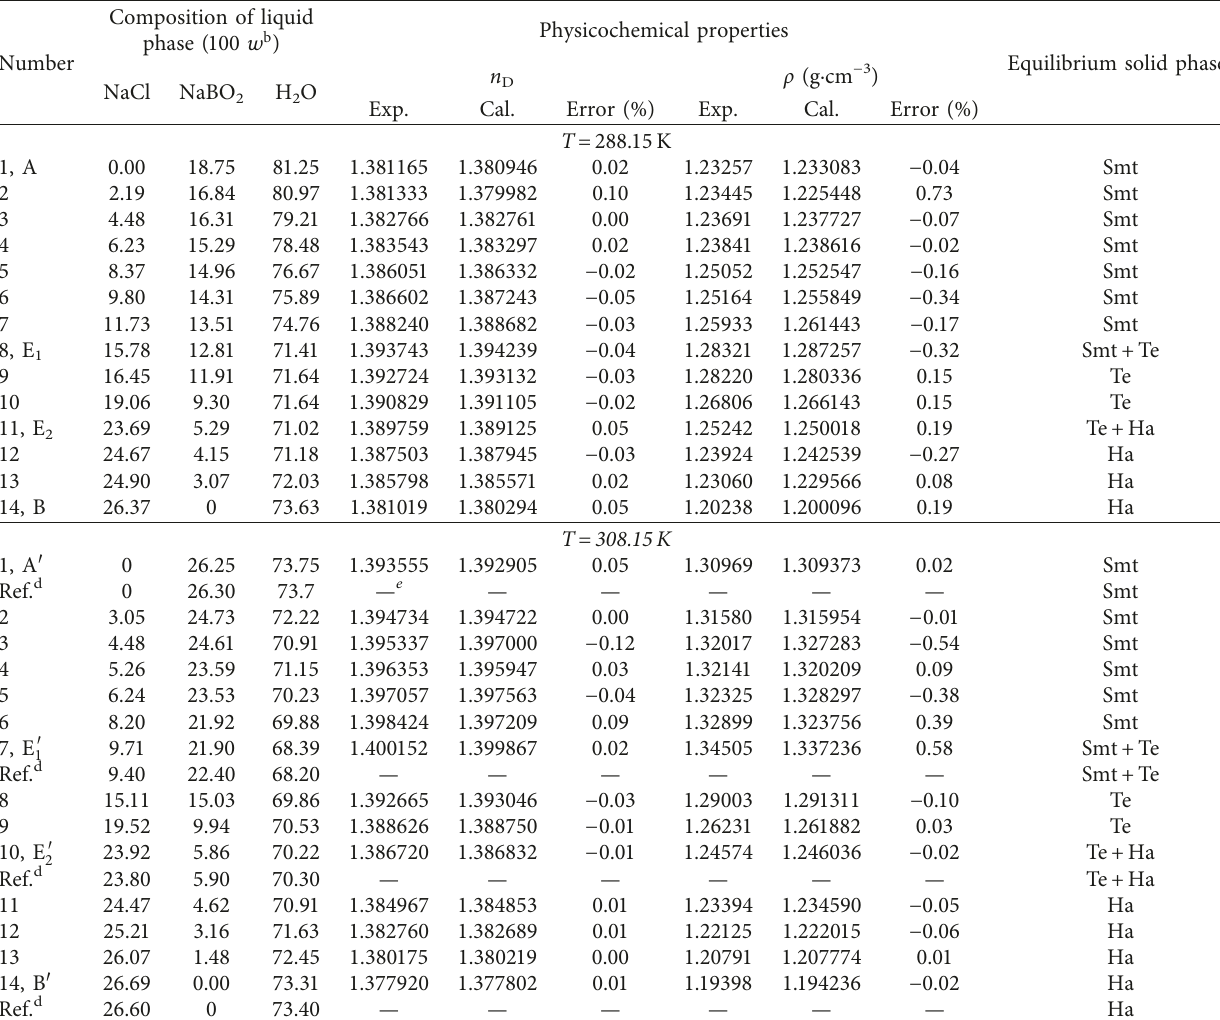
� 288.15 and 308.15K and 0.1MPa. a 2 +H 2 O) at T